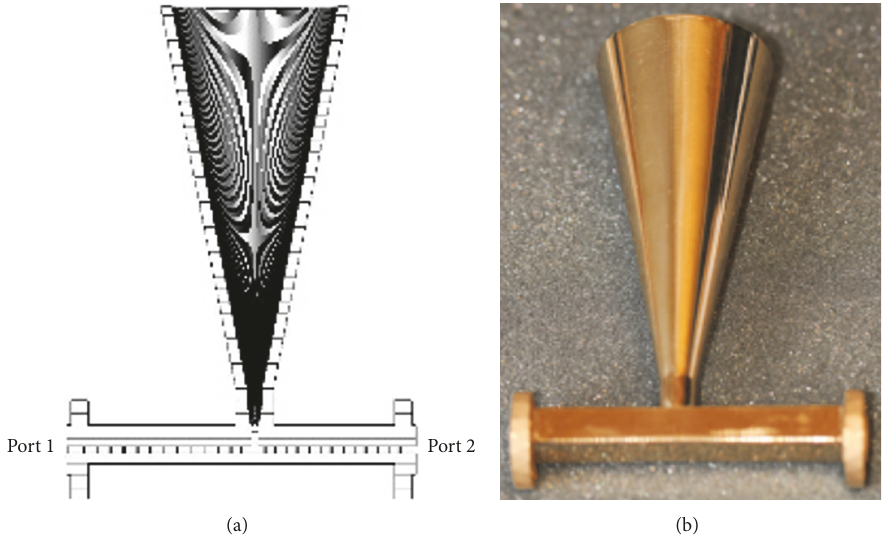
Figure 7: 3D printed E-band front end: (a) perspective view and (b)